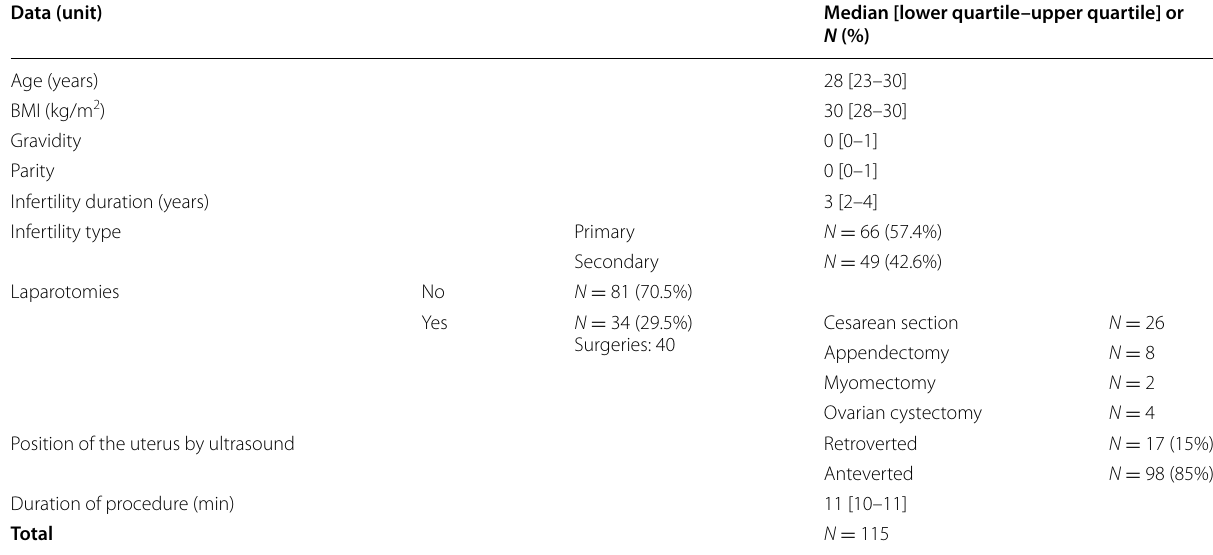
N number, % percentage, kg kilogram, m